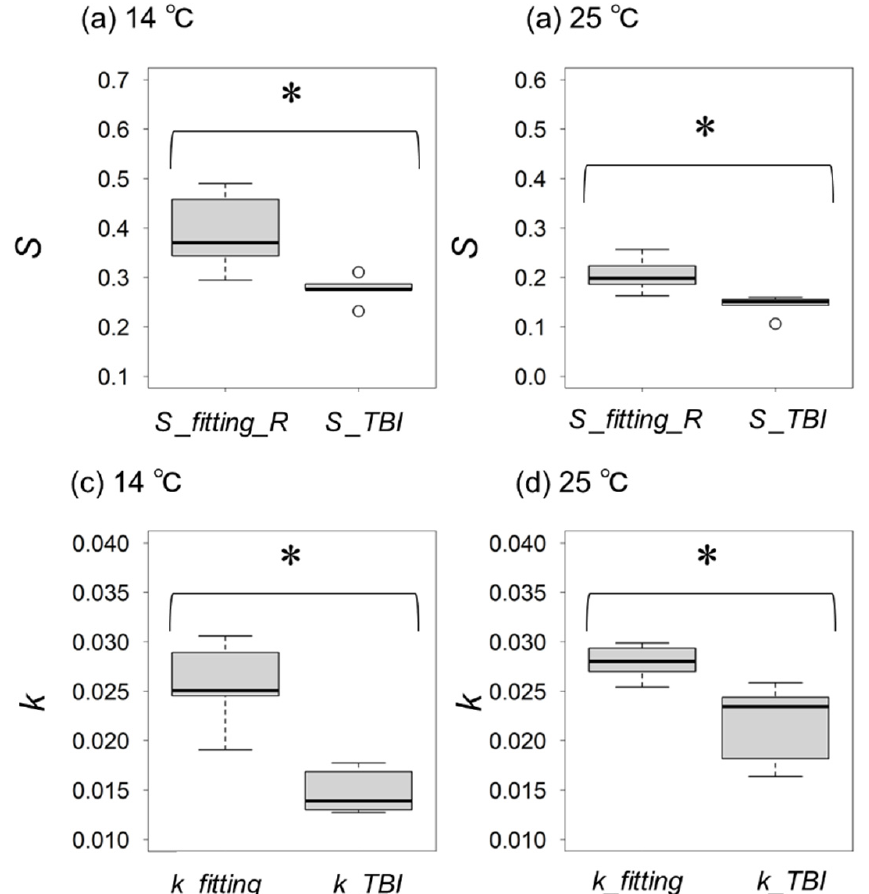
Figure 4. Comparison of the stabilization factor of rooibos tea determined by fitting an asymptote model to time series data of rooibos tea decomposition ( S_fitting_R , see Equation (8)) and by the TBI approach ( S_TBI , determined based on the mass loss of green tea, assuming that S of rooibos tea equals that of green tea) at ( a ) 14 °C and ( b ) 25 °C. The decomposition constant k of rooibos tea determined by fitting an asymptote model to time series data of rooibos tea decomposition ( k_fitting , see Equation (6)) and by the TBI approach ( k_TBI ) at ( c ) 14 °C and ( d ) 25 °C. * p < 0.05. It was not clear what caused the differences between S_fitting_R and S_TBI and inaccurate TBI determination with the nonwoven tea bags. Changes in the mesh materials could influence the decomposition pattern of both teas via several mechanisms. First, mesh size could have altered the decomposition pattern through a change in the water content inside the tea bags. Second, the community composition of decomposers involved in tea decomposition could also have changed, influencing the decomposition pattern. Third, the nonwoven mesh itself might have contained nutrients that could have altered the decomposition pattern. However, these changes in decomposition pattern could not explain the inaccurate TBI determination with nonwoven tea bags because the environmental changes caused by the mesh change affected the green and rooibos teas equally. In other words, at least under the same environmental conditions provided by the changes in mesh materials (i.e., altered water content, shift in decomposer community, or nutrient enrichment), even woven tea bags cannot accurately determine the TBI. It is possible